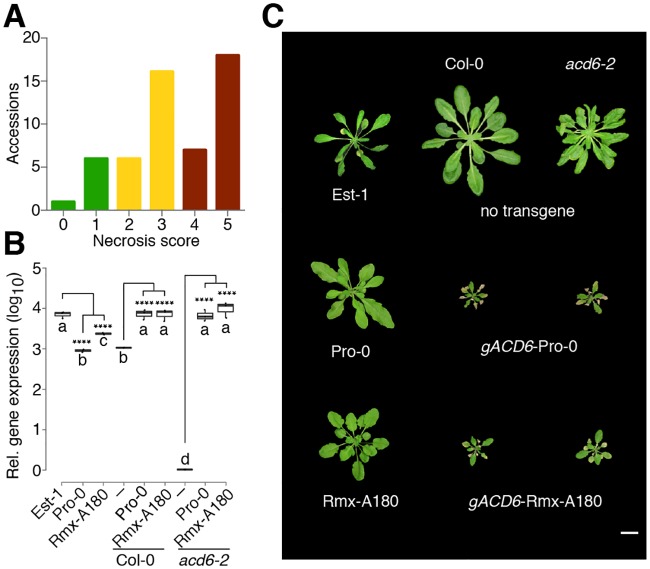
Genetic background dependence of ACD6-Est effect.(A) Variation of necrosis in 54 natural accessions (n = 6 each) with ACD6-Est alleles. Broad-sense heritability H2 is 0.89. (B) Accumulation of ACD6 mRNA in various genetic backgrounds (n = 3), as measured by qRT-PCR. Asterisks indicate significant differences in pairwise Student’s t-tests (p<0.0001; Holm adjusted). Letters indicate significantly different groups (p<0.0001; post hoc Tukey’s HSD). (C) Representative non-transgenic and ACD6 transgenic lines at 5 weeks of age in Col-0 and acd6-2 backgrounds. Est-1, Pro-0 and Rmx-A180 are shown for comparison on the left. Scale bar, 10 mm.